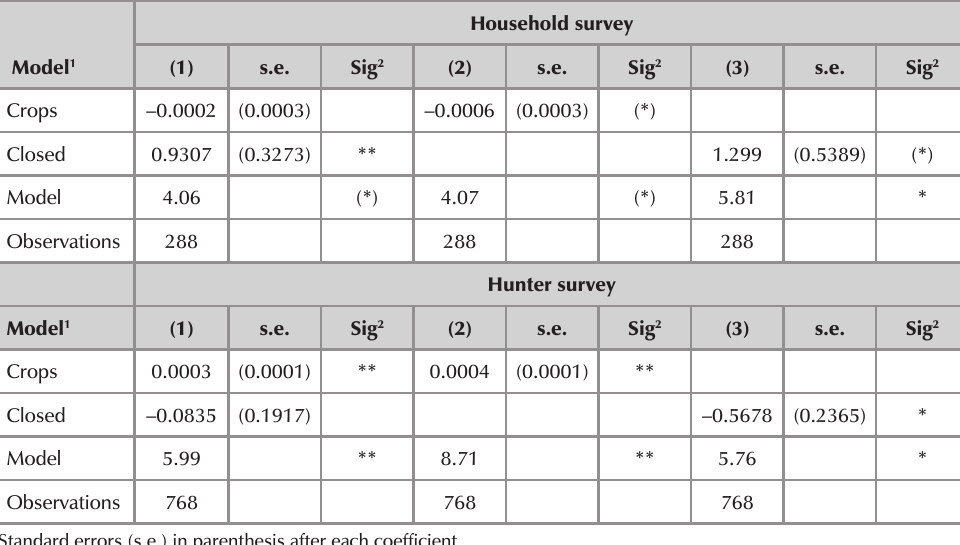
Logistic regression for the months in which hunters hunt (1) or not (0), regressed against whether the month is one in which crops are predominately harvested and whether the month is in the closed or open season, for two datasets (household survey and hunter